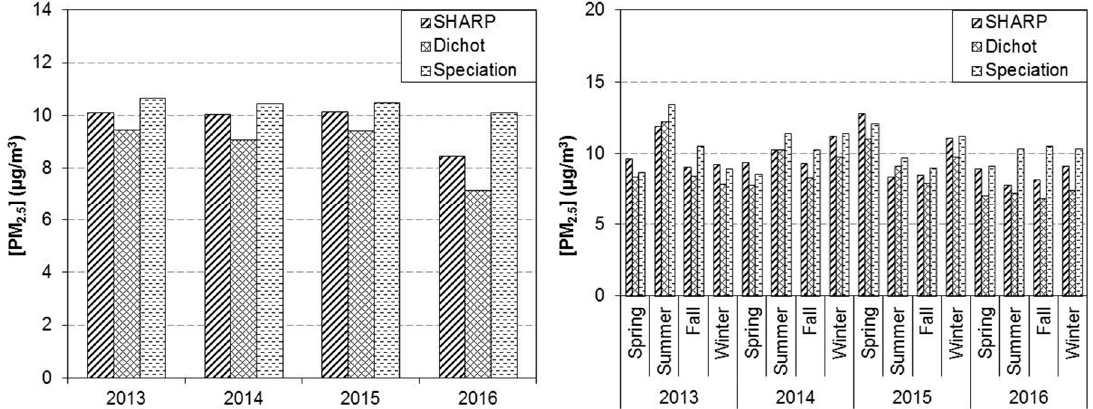
Figure 6. Annual and seasonal averages of PM 2.5 concentrations by the SHARP 5030, Dichot, and Speciation samplers from 2013 to 2016 at four collocated stations (Dichot and Speciation in the figure refer to the Dichot and Speciation samplers).